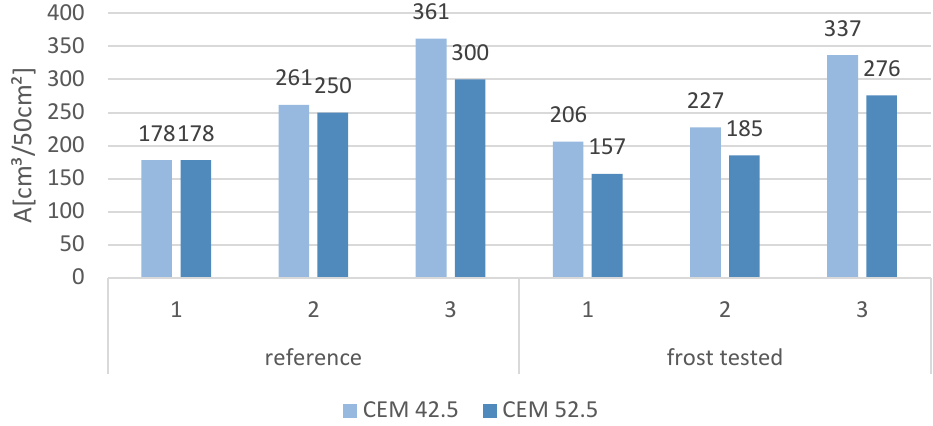
Figure 14. Loss of volume during abrasion testing after frost test and without frost test.